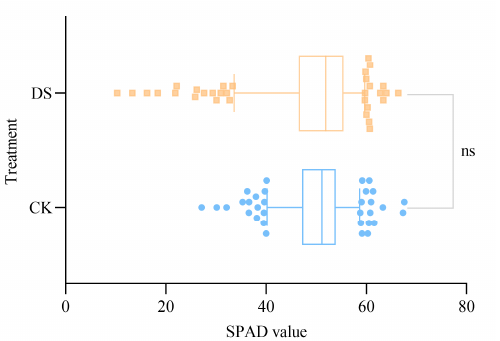
Figure 1. SPAD values of 335 varieties of wheat leaves under di ff erent soil moisture conditions. CK, control; DS, drought stress; whisker, 5–95%; ns, no statistically signi fi cant di ff erence in SPAD values between the CK and DS treatments ( p > 0.05).